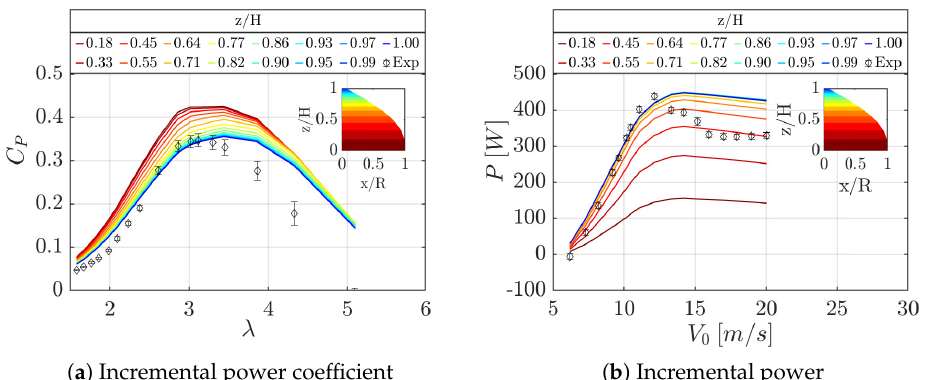
Figure 7. Incremental performance contributions of Troposkein